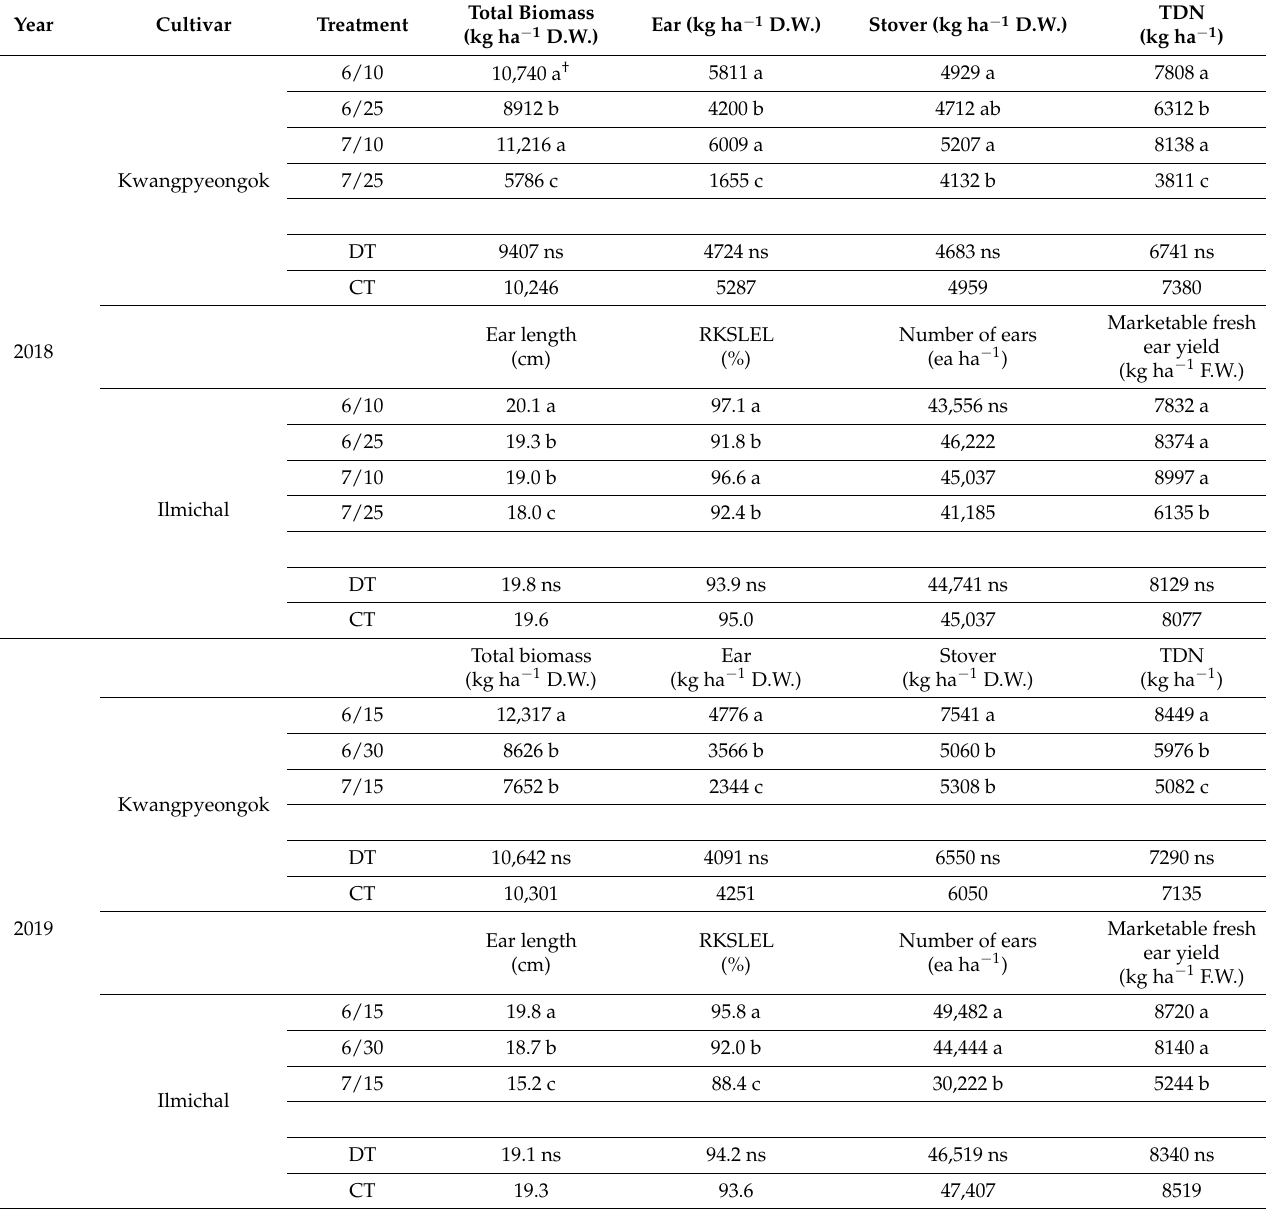
Table 10. Yield and yield components of two maize cultivars (Kwangpyeongok and Ilmichal), as affected by the planting date and tillage practice (deep tillage, DT; conventional tillage,